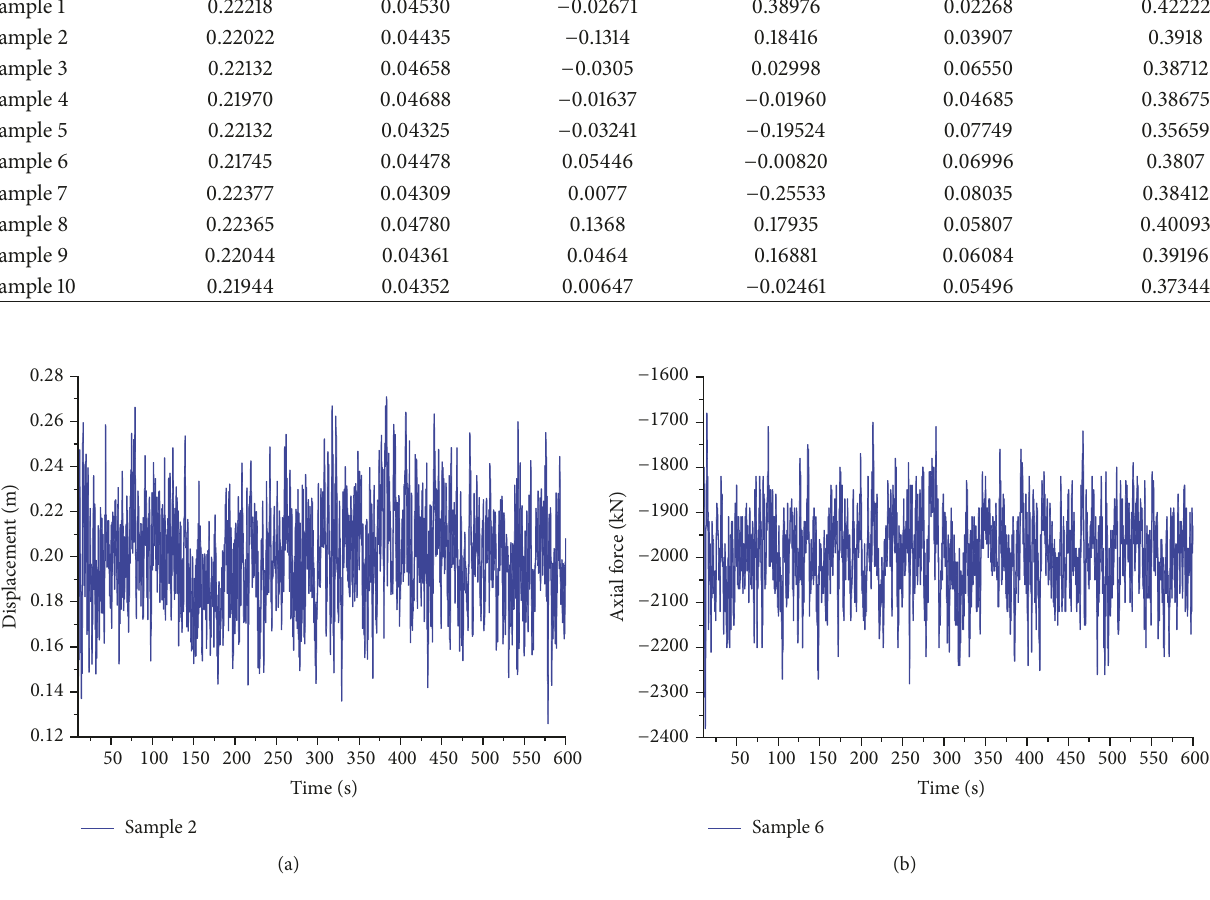
Figure 13: Time history curve of low tower in the tower-line system under wind field 1.